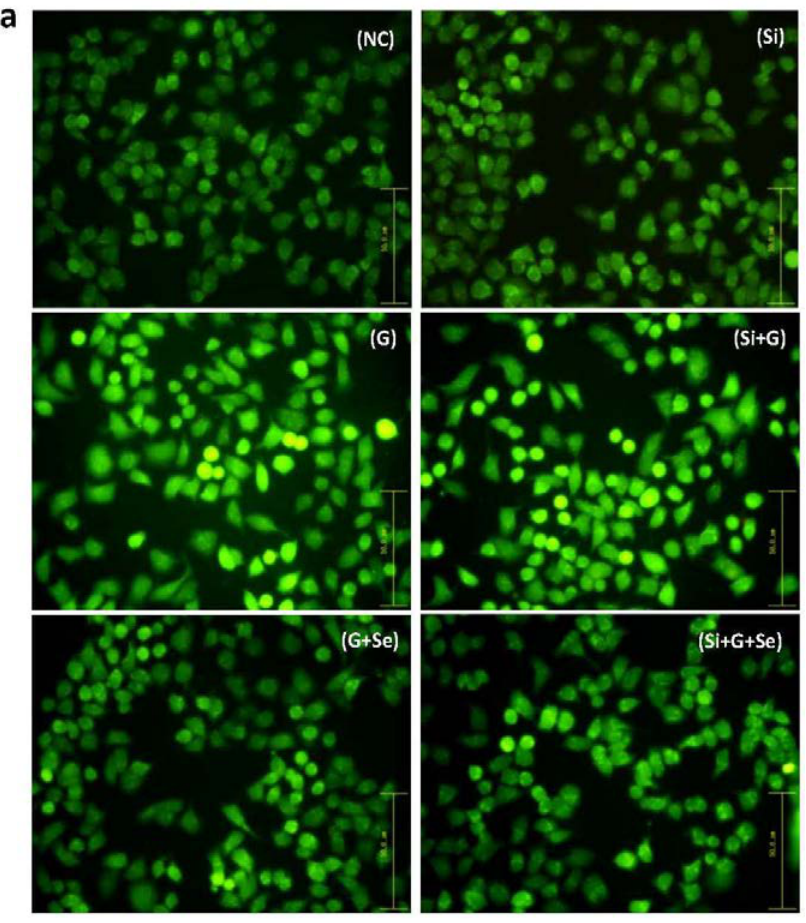
Figure 5. Cont. Figure 5.